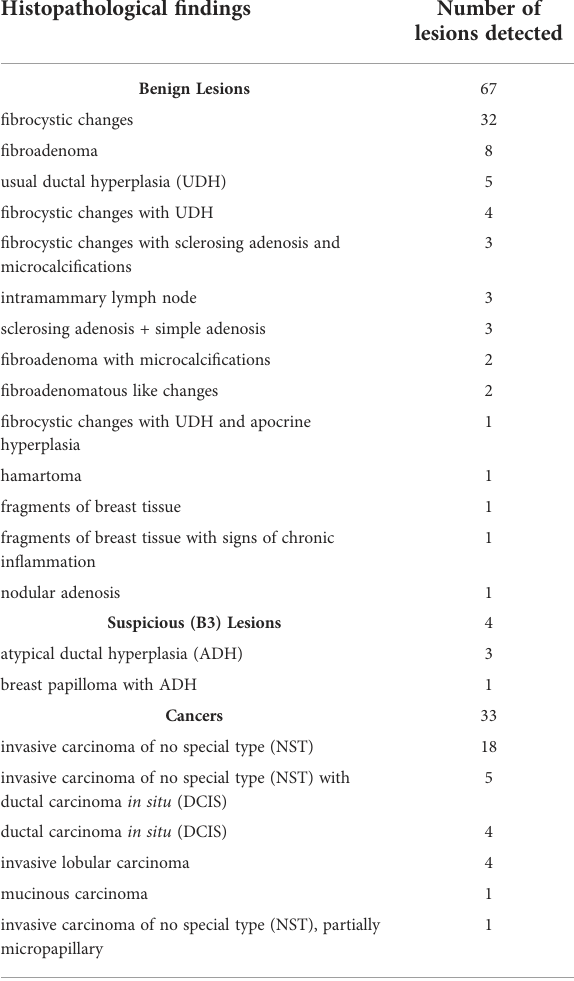
TABLE 2 Distribution of lesions visible in